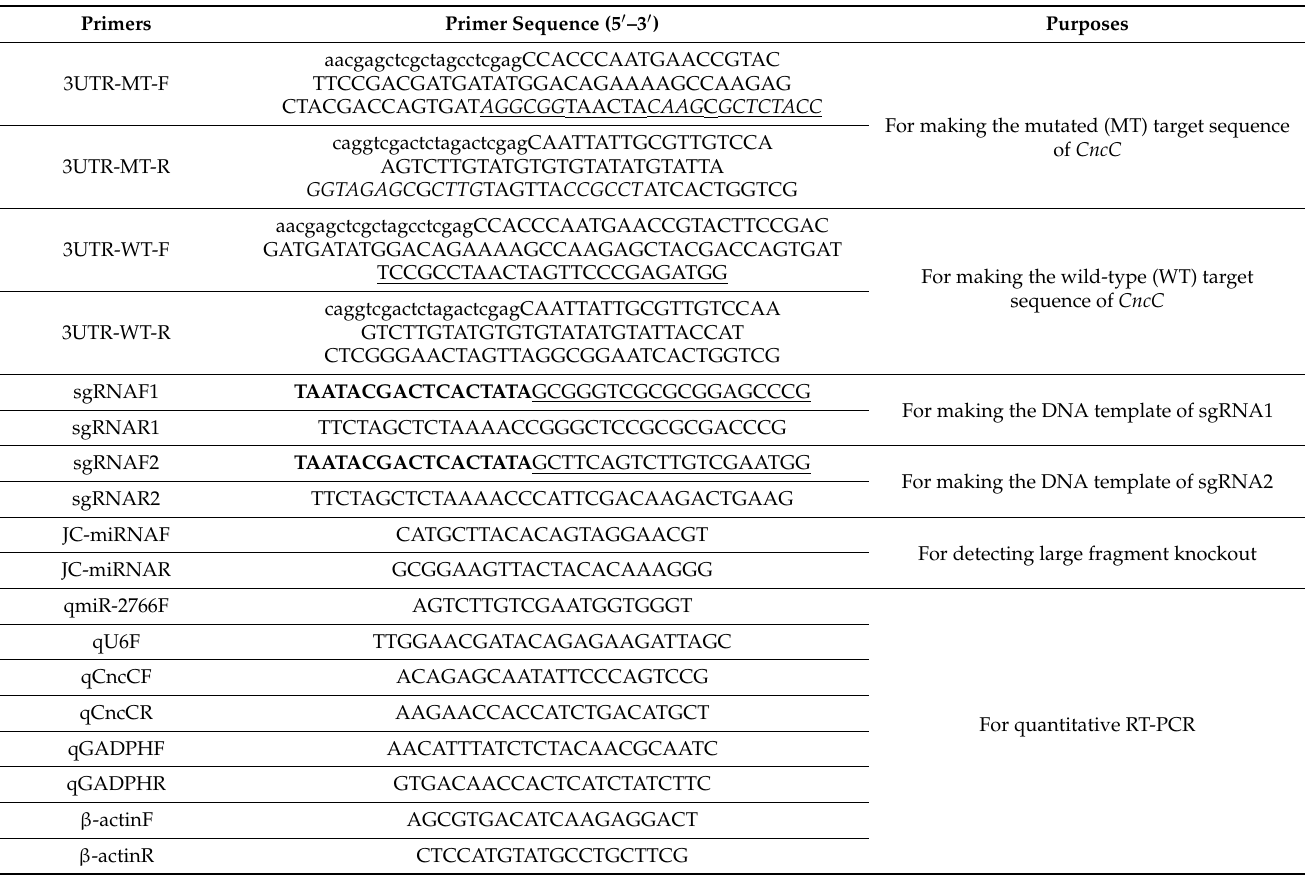
Table 1. Primers used in this study for the construction of the luciferase reporter vector, for gRNA DNA temple synthesis, and for detecting large fragment